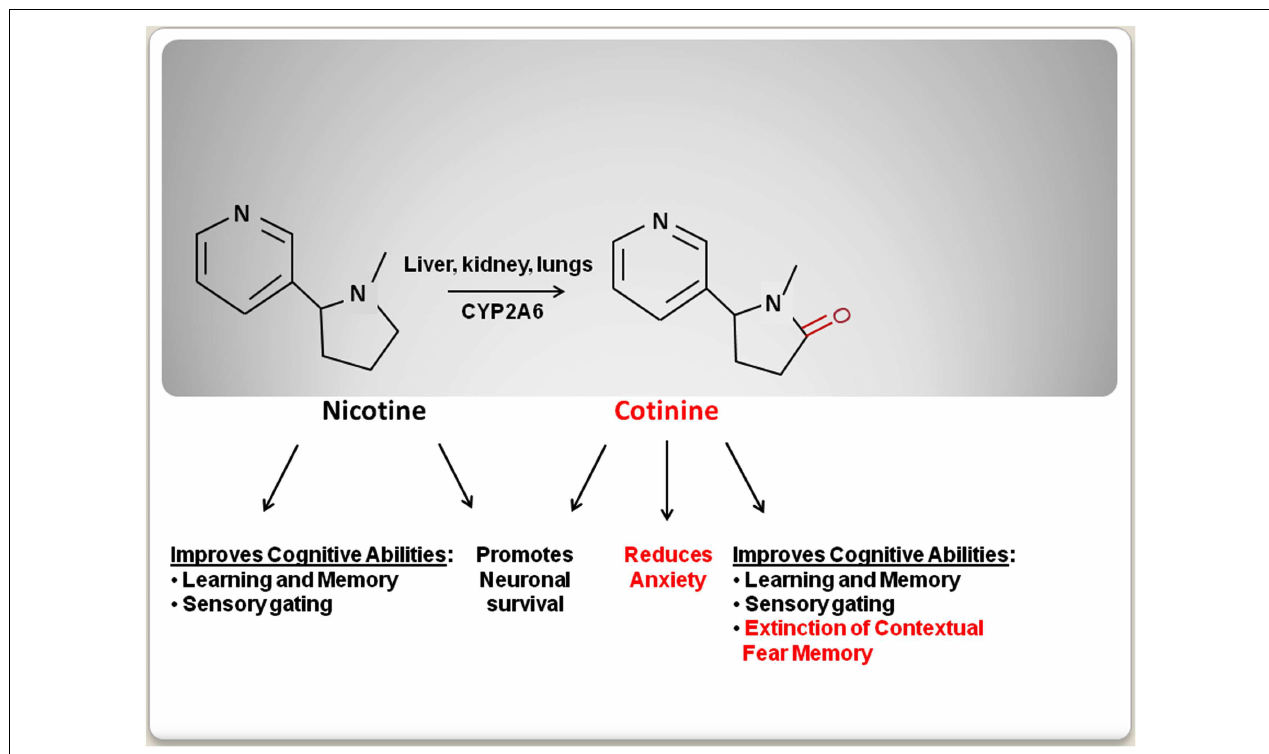
FIGURE 1 |A schematic comparison of the behavioral effects of nicotine and